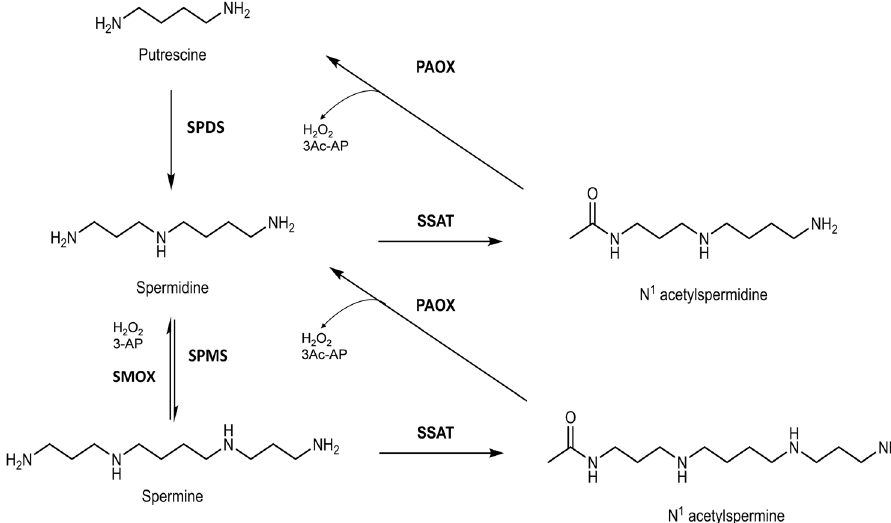
Fig. 1 Polyamine catabolic pathways. The two intersecting PA catabolic pathways are depicted. The fi rst pathway involves SSAT that produces N 1-acetylated PAs, which are either excreted from the cell through their speci fi c transport systems or oxidized by PAOX, resulting in Put or Spd, H 3Ac-AP. The second pathway involves a one-step reaction where Spm is directly oxidized by hSMOX to produce Spd, H 2 O 2 and 3-AP. SPDS (spermidine synthase) and SPMS (spermine synthase) are the two enzymes that, through the addition of the aminopropyl group to putrescine and spermidine, generate spermidine and spermine,